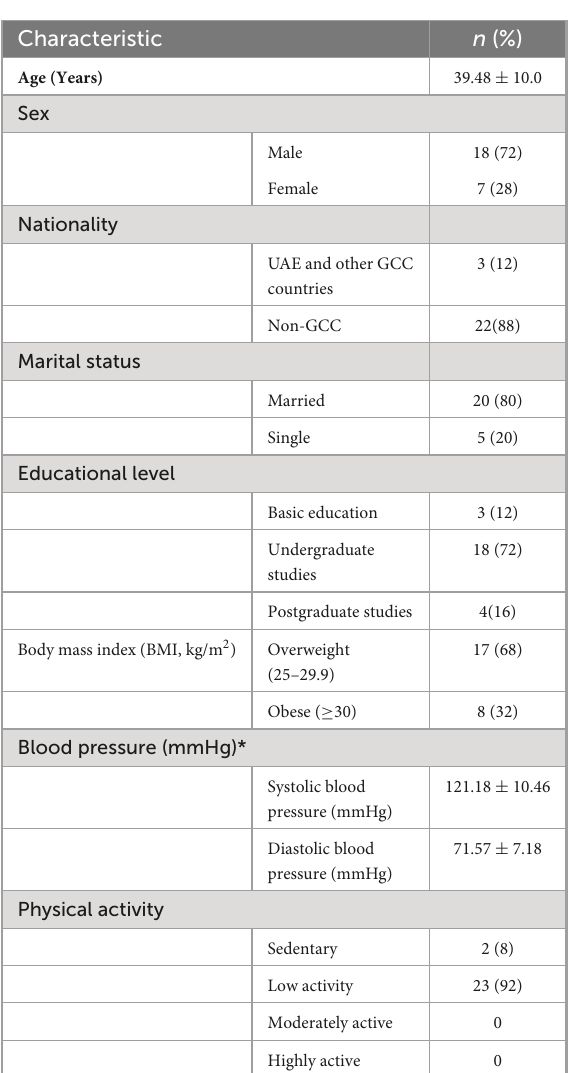
TABLE 1 Participants’ sociodemographic characteristics (n =